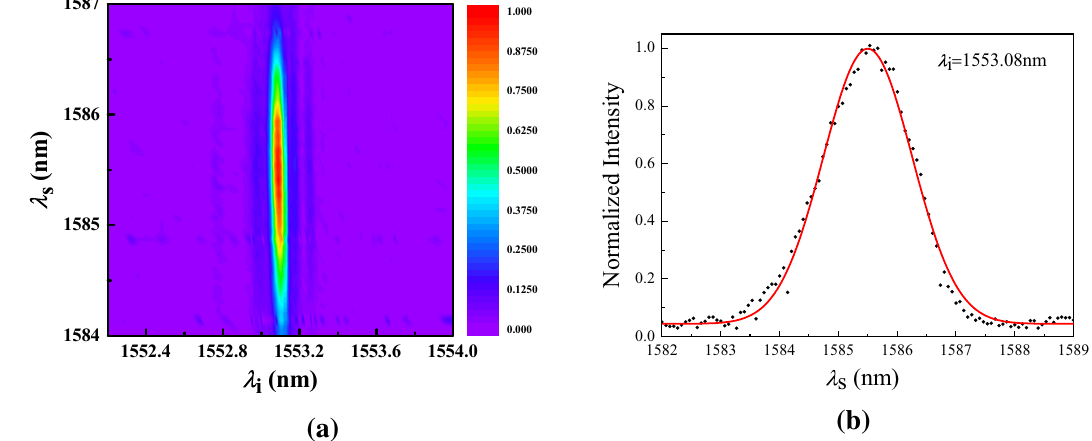
Figure 3. Experimetanl result of the JSI measurement. ( a ) JSI obtained by combining signal spectra measured at 180 idler seed wavelengths. The horizontal resolution depends on the seed linewidth and sweep step, and the step size is set as 0.01 nm. The vertical resolution is 0.065 nm that is determined by the resolution of the optical spectrum analyzer. ( b ) Spectral profile of the signal light measured when the idler seed wavelength is set as 1553.08 nm. The black dots represent the data obtained from the spectrometer and the red solid curve is fitted with a Gaussian